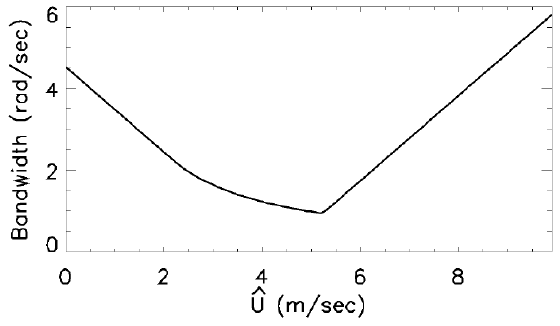
Figure 8. Behavior of the spectral bandwidth